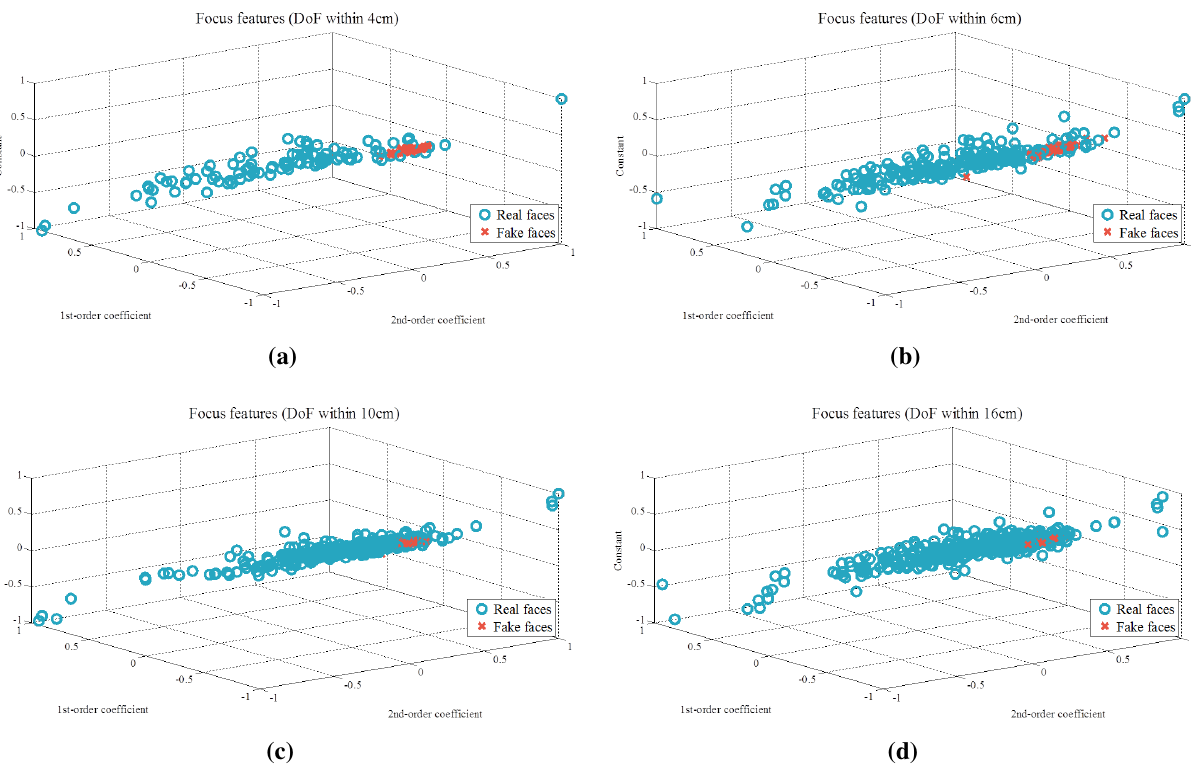
Figure 10. Distributions of focus features (DoF ( a ) within 4 cm, ( b ) within 6 cm, ( c ) within 10 cm and ( d ) within 16